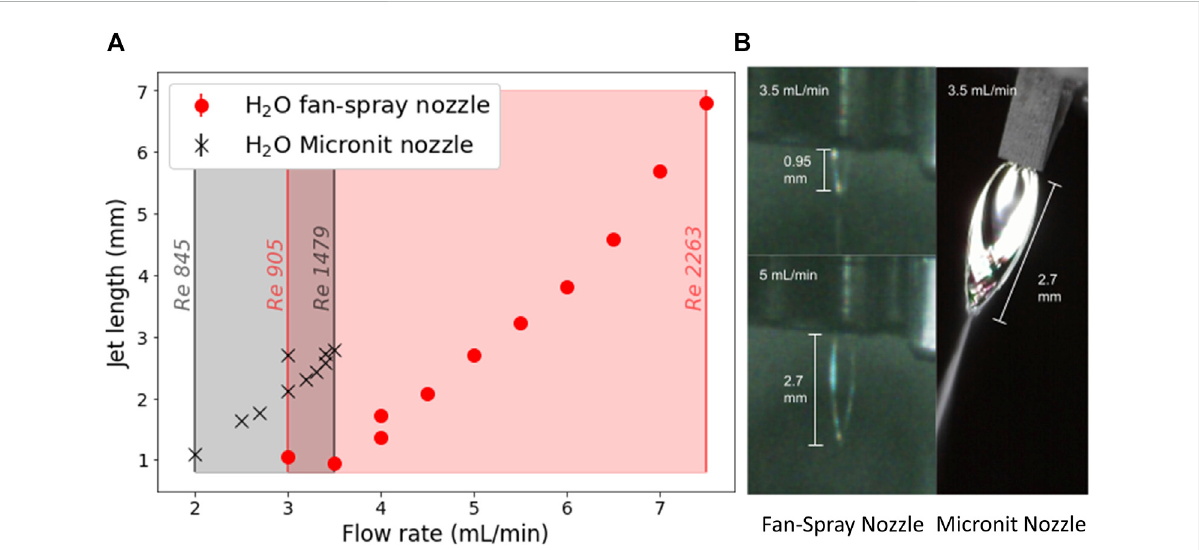
FIGURE 2 (A) A graph ofthelengthofthewater jetagainst fl ow ratefor theMicronit nozzle(black) and thefan spraynozzle(red). The length ofthejet was measuredfromtheimagesusingImageJandscaledusingreferenceobjectsinthesameimage.The fl owratewasmeasuredattheHPLCpumphead, and was increased until the sheet became unstable. The Reynolds numbers shown on the graph were calculated using a characteristic length of 50 μ mand70 µmfortheMicronitandfanspraynozzlesrespectively,and20 ° Cwater. (B) Imagesshowingthelengthofasheetproducedbythe Micronit nozzle at 3.5 ml/min (right), and the fan spray sheet for the same fl ow rate (top left) and with the same length (bottom left). The Micronit nozzle sheet has noticeably more structure and is clearly wider than the sheets produced by the fan spray